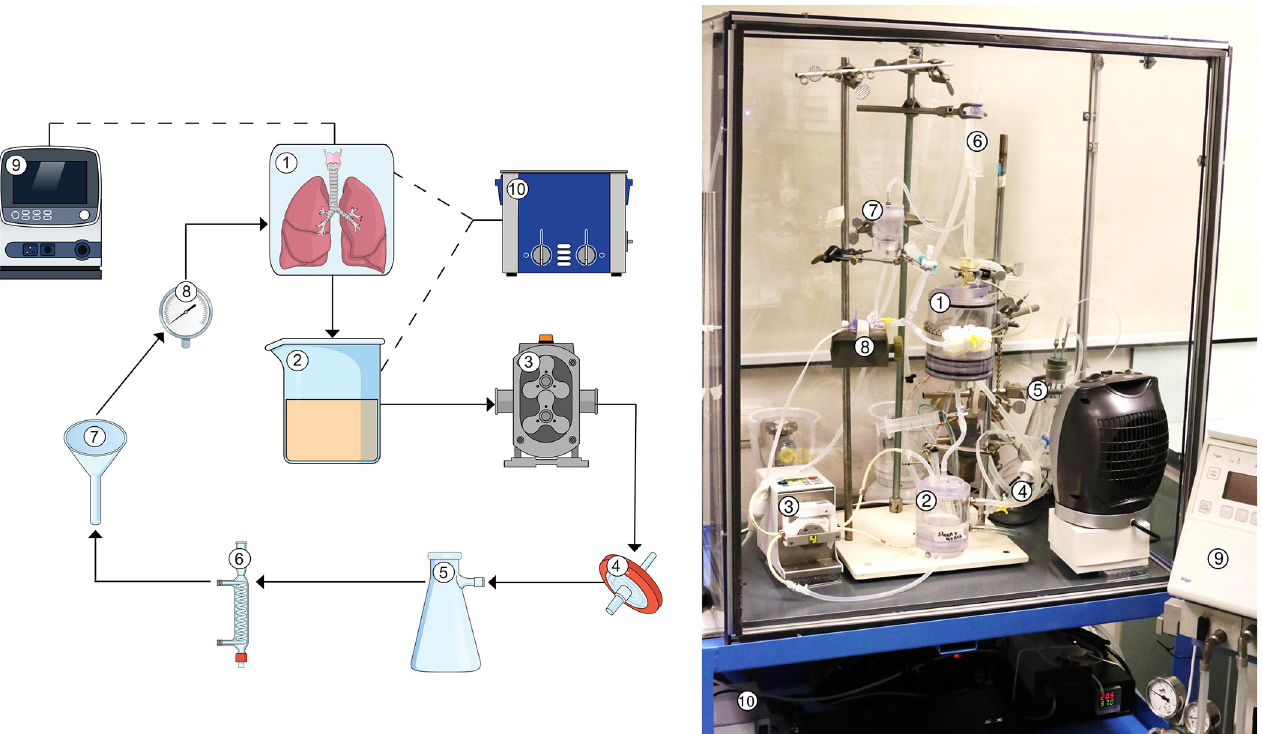
Fig 2. Schematic overview of the rat ex vivo lung perfusion model. Lungs from healthy or brain-dead donor rats were subjected to 6 hours ex vivo lung perfusion (EVLP). The EVLP circuit consisted of a (1) graft humidity chamber, (2) reservoir, (3) roller pump, (4) leukocyte filter, (5) deoxygenator, (6) heat exchanger, (7) funnel, (8) pressure sensor, (9) ventilator, and a (10) water bath.